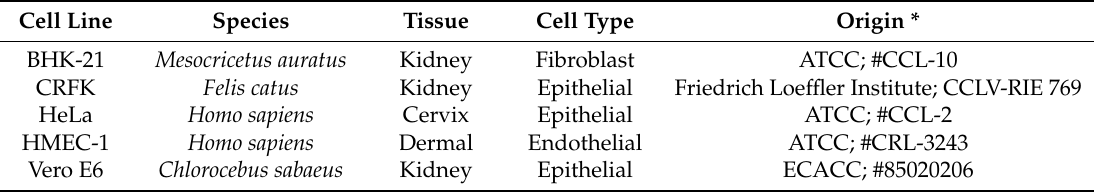
Table A1. Characteristics of applied eukaryotic cell lines.